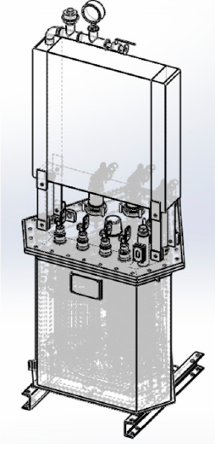
Figure 7. Design drawing of evaporative cooling transformer.